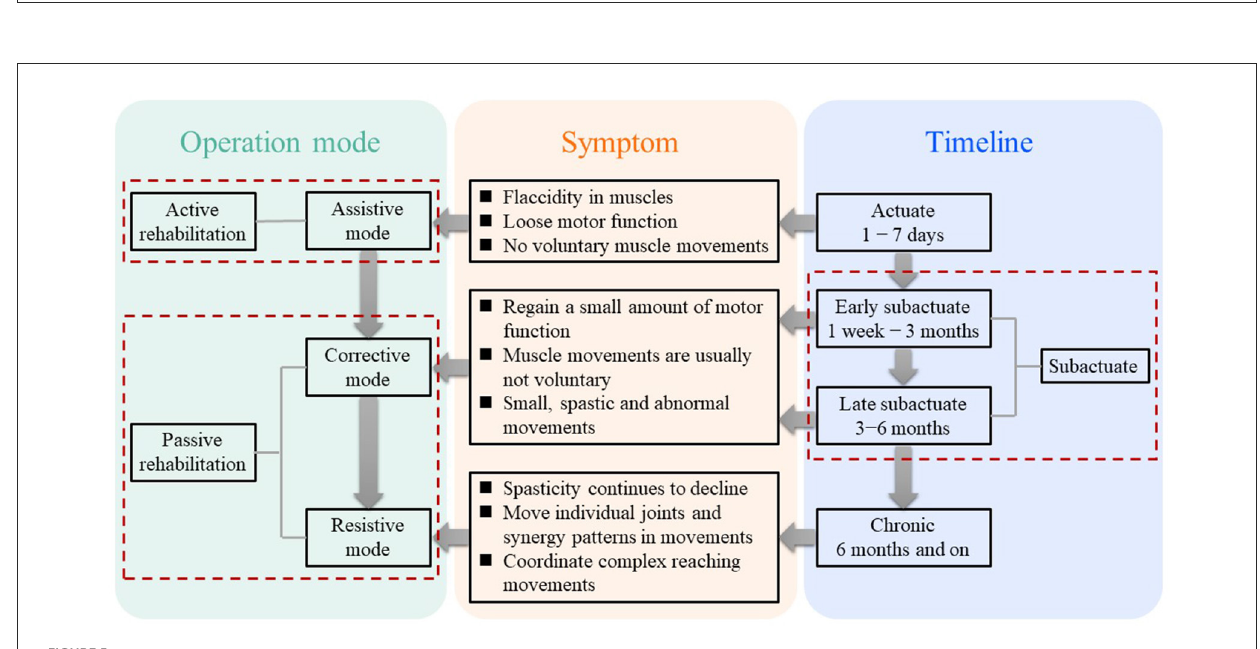
FIGURE5 Three timeline phases after a stroke, corresponding symptom for each phase, and corresponding operation mode for each